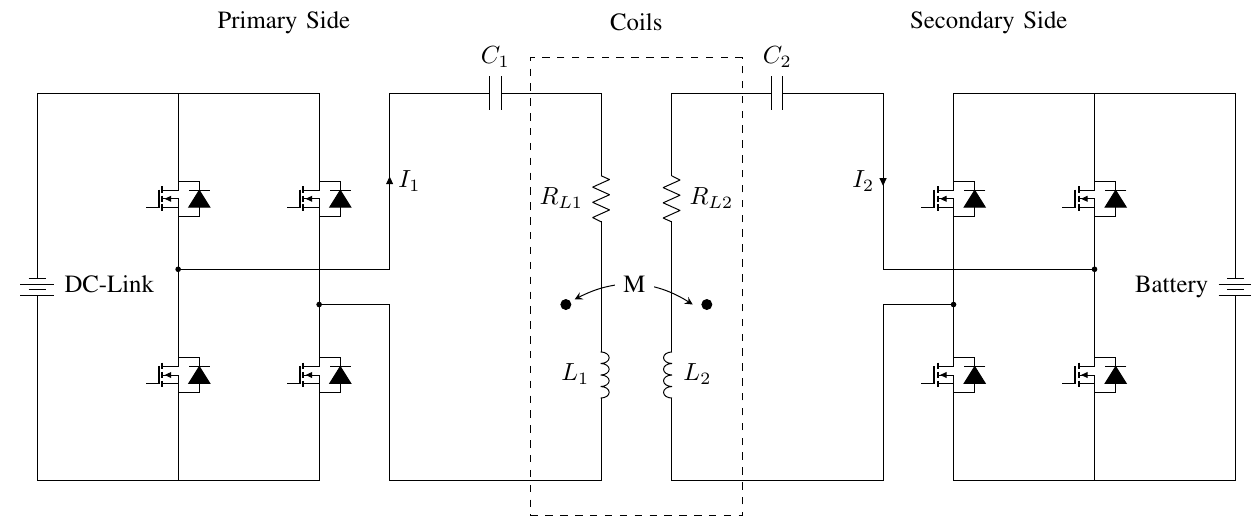
Fig. 3. Topology of the analyzed bidirectional wireless